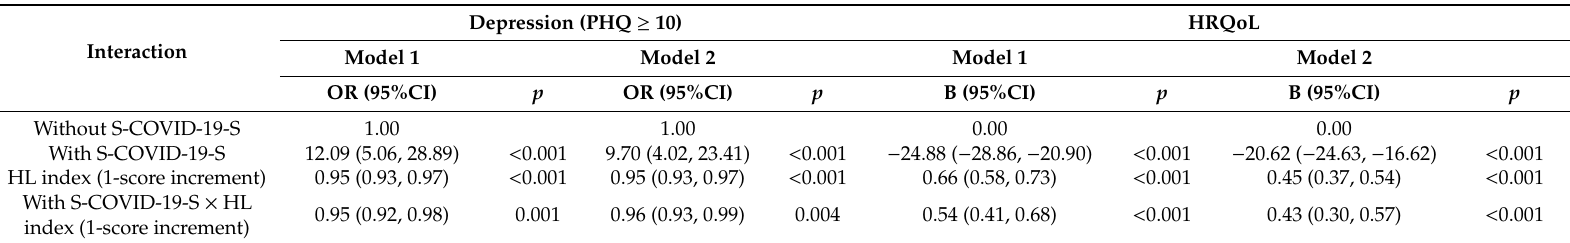
Table 3. Interaction e ff ect of suspected Covid-19 symptoms and health literacy on depression and health-related quality of life ( n = 3947).